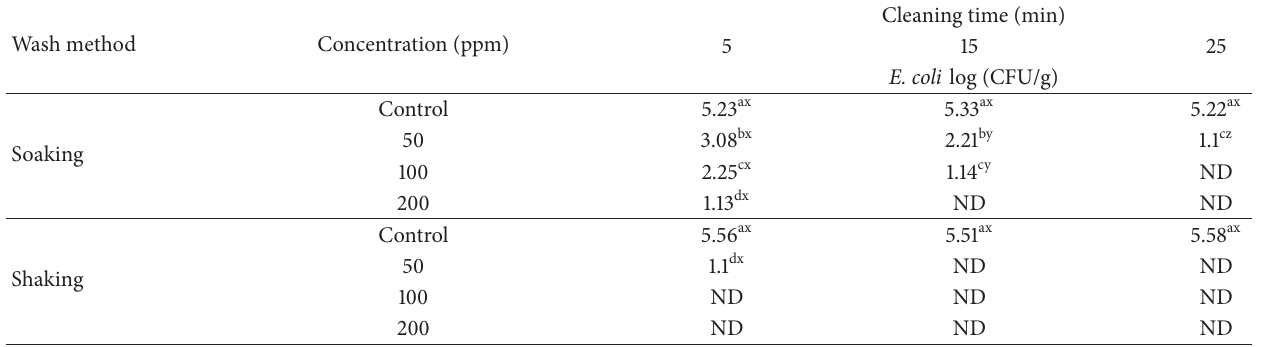
Table 5: Escherichia coli reduction of tilapia fillets disinfected by soaking or shaking treatments at different chlorine dioxide concentrations. Wash method